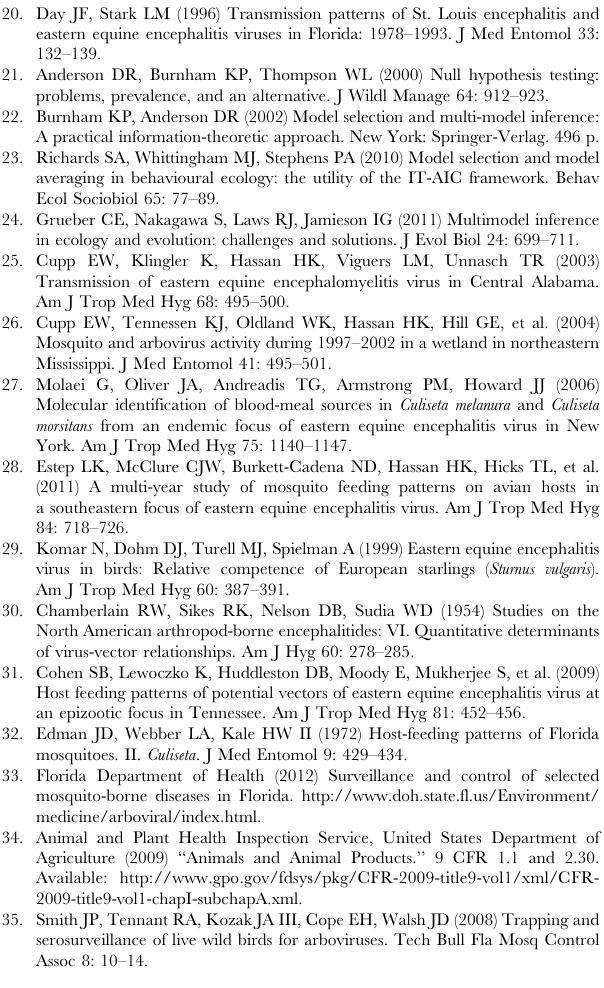
Table S1 EEEV exposures of sentinel chickens in Walton County, Florida between 2009 and 2010, as identified through seroconversions from EEEV-antibody negative statuses to positive statuses.